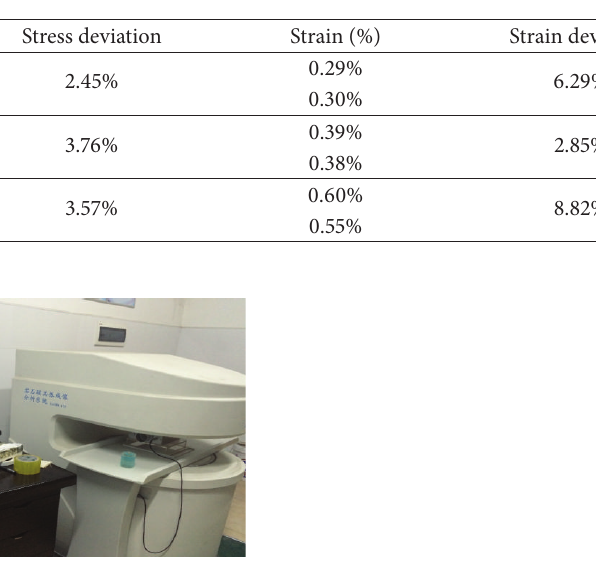
Table 5: Comparison of the peak stress and the corresponding dynamic strain values between prismatic and cylindrical specimens under approximately equal strain rates.